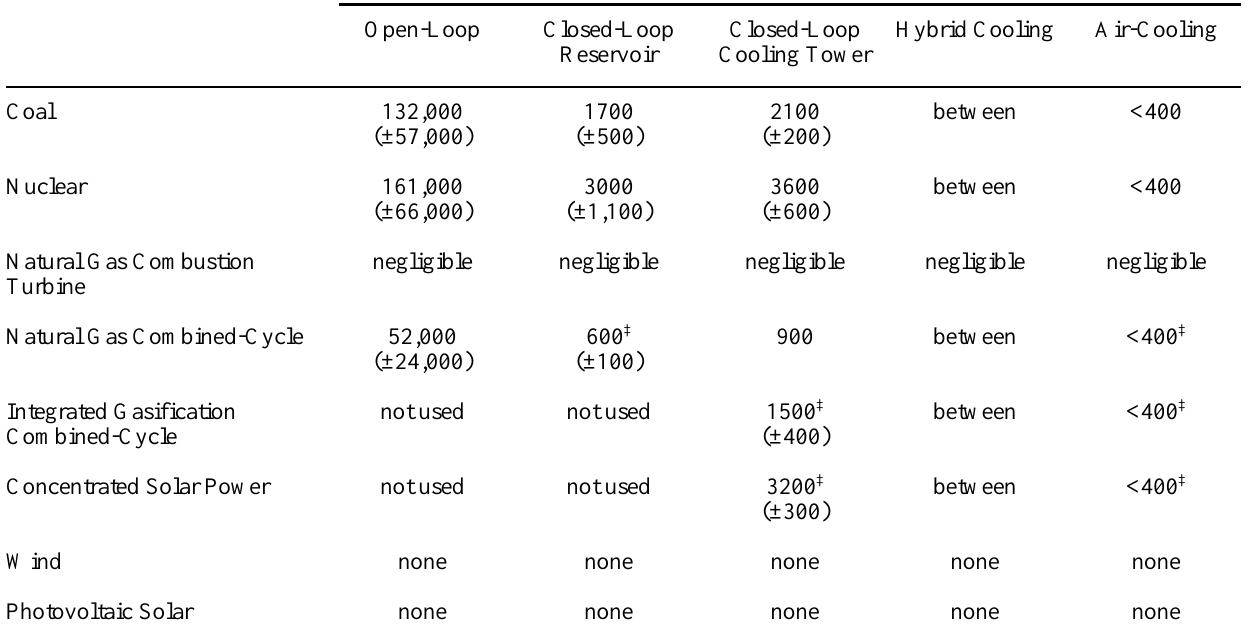
Table 1 . Water withdrawal reported volumes for different fuels and cooling technologies (Gleick 1994, Goldstein and Smith 2002a, Woods et al. 2007, National Renewable Energy Laboratory 2008). Air-cooling requires negligible water and is compatible with all of the technologies listed. Cooling Technologies – Water Withdrawal (L [MWh] -1 )† Open-Loop Closed-Loop